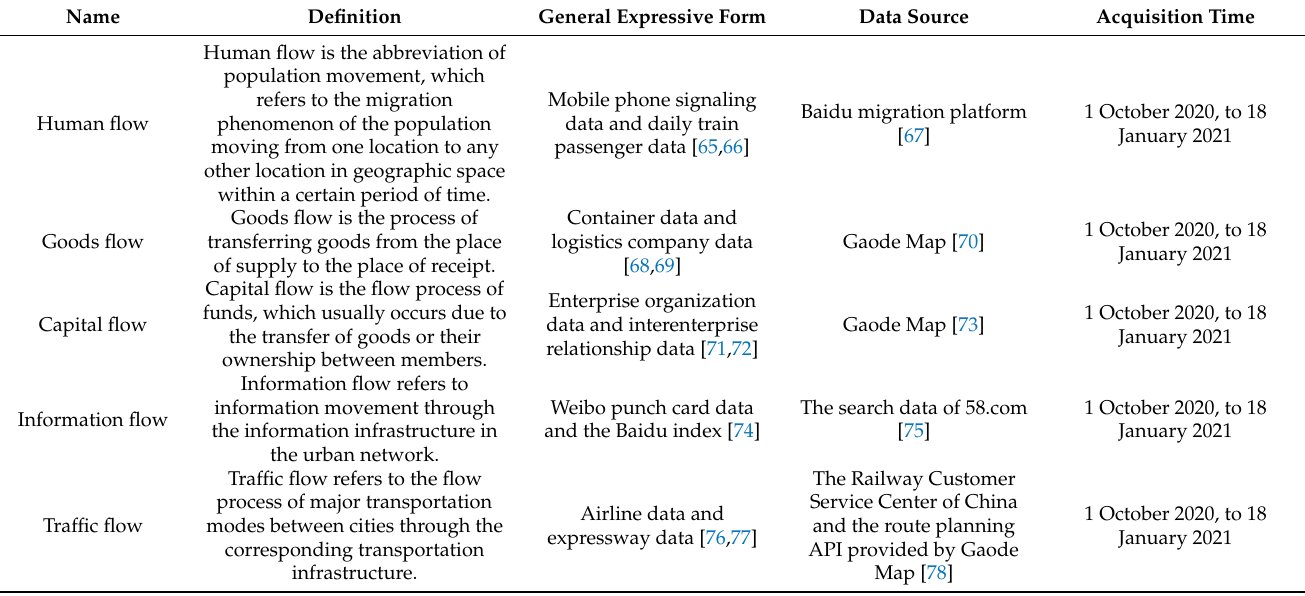
Table 1. Basic information and data sources for element flows.